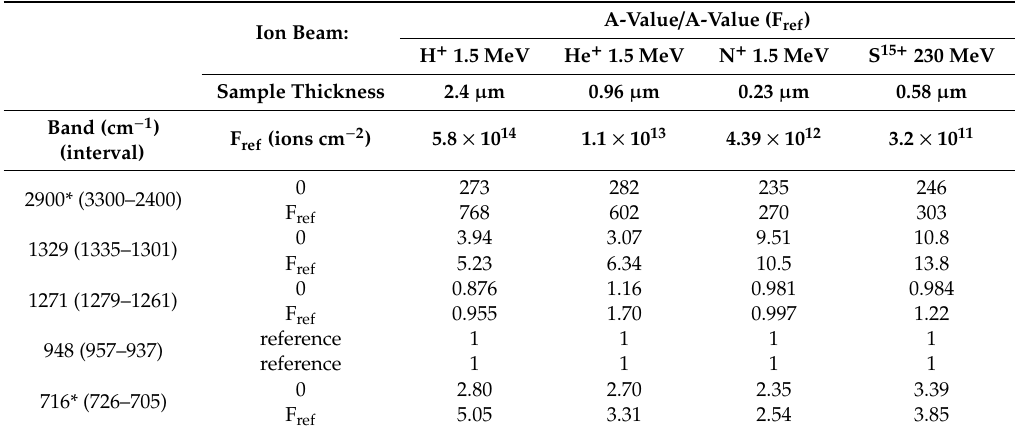
Table 2. Relative A-values (integrated absorbance ratios), before and during irradiation. Ratios refer to the 948 cm − 1 band, taken as reference. F = 0 means non irradiated sample and F ref is the fluence for which the absorbance ratios were measured (4th line). Sample thickness values are also shown.